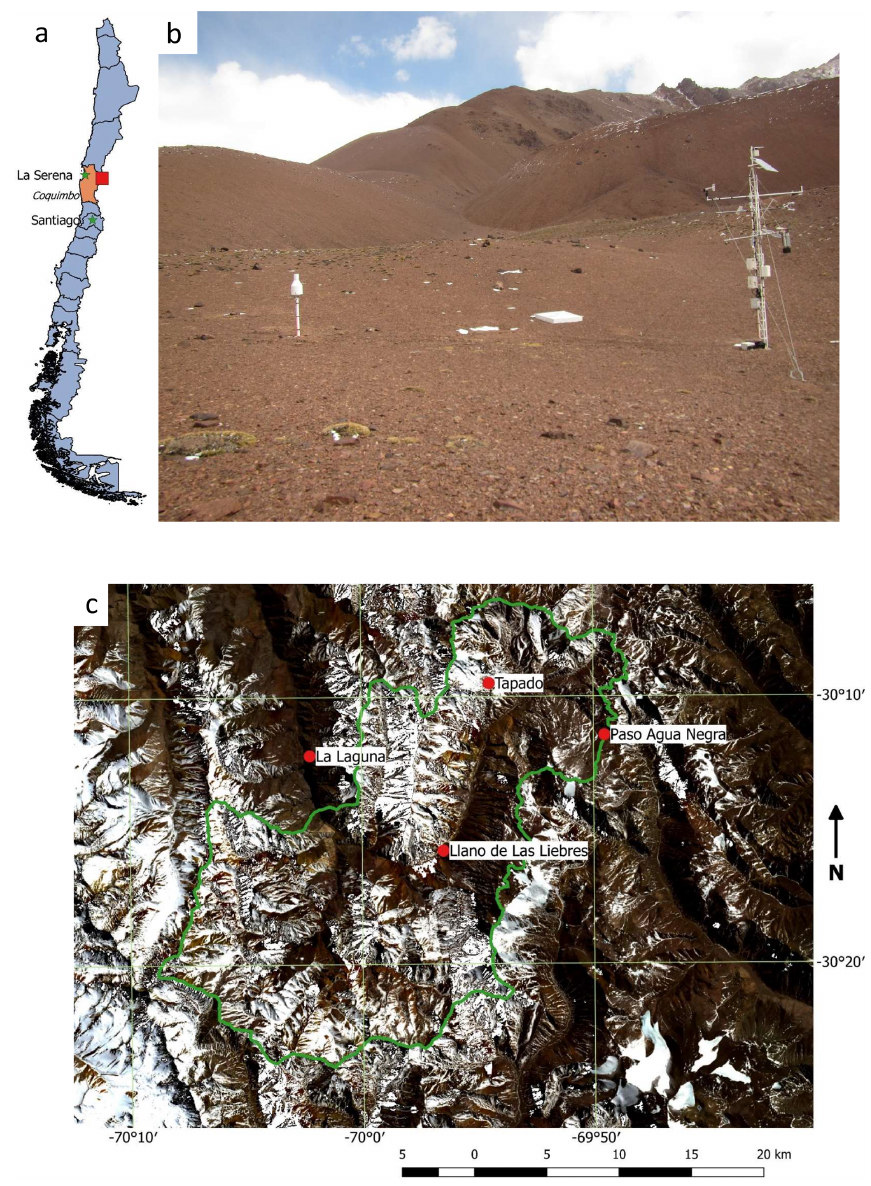
Figure 1. (a) Map of Chile with the Coquimbo Region (orange) and the study area location (red box). (b) Tapado AWS on 26 April 2018 showing the Geonor precipitation gauge (left), which is 10m from the central mast of the AWS (right). (c) Map of the borders of the La Laguna catchment (green) with the AWS locations (red points). Landsat 8 images of 29 August 2017 are used as the background and the maps and photo were made by Annelies